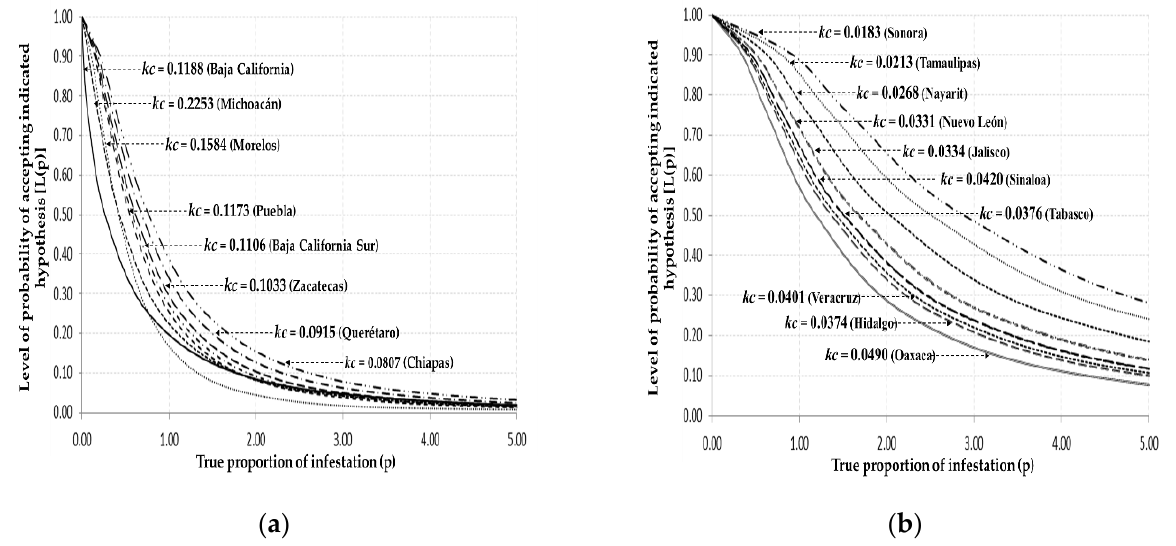
Figure 4. Operational Characteristic (OC) function for the SPRT sequential sampling plans of the Asian citrus psyllid for 18 citrus producing states of Mexico. α = 0.1, β = 0.1, threshold = 0.2 adults/trap. ( a ). kc ≤ 0.05. ( b ). kc > 0.05. Table 4. Decision stop lines of the SPRT sequential sampling plans for the Asian citrus psyllid for 18 citrus producing states of Mexico, OC, and ASN functions for a threshold = 0.2 adults/trap. α = 0.1, β =